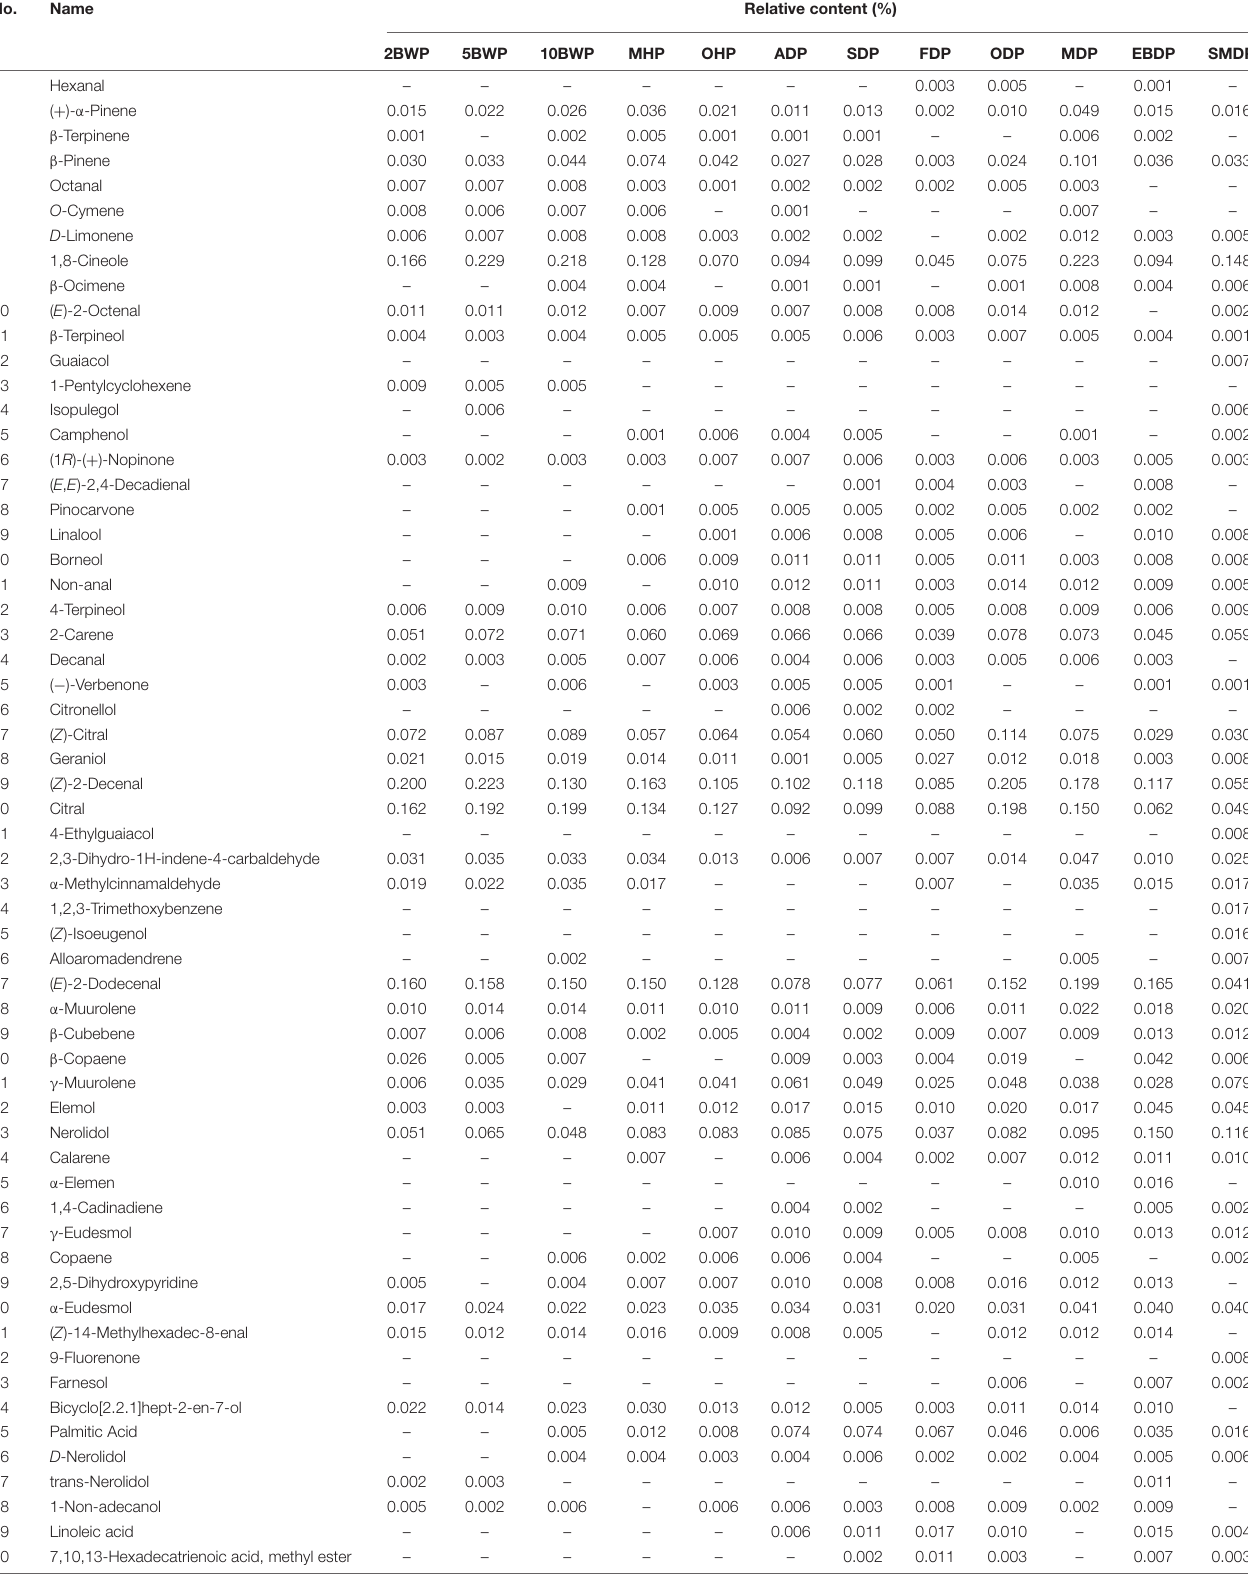
TABLE 1 | Relative content of volatiles in pericarp of Amomum tsao-ko .